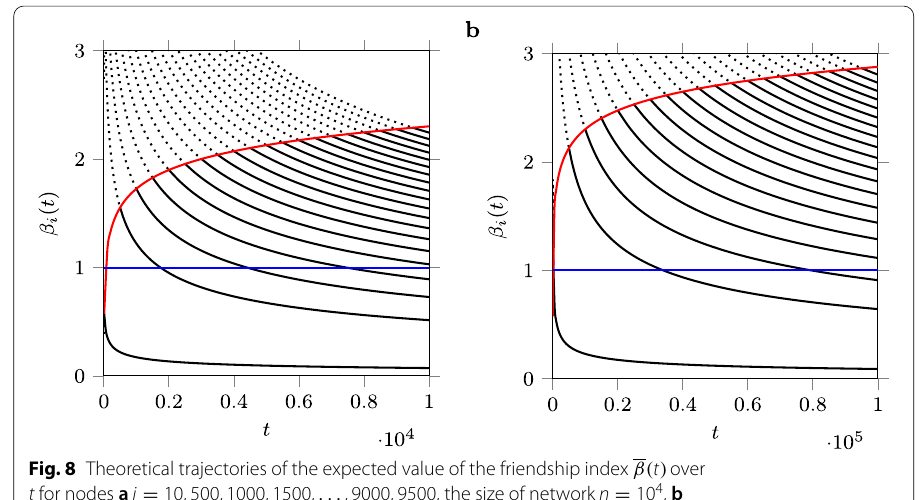
Fig. 8 Theoretical trajectories of the expected value of the friendship index β( t ) over t for nodes a i = 10,500,1000,1500, ... ,9000,9500 , the size of network n = 10 4 , b i = 100,5000,10000,15000, ... ,90000,95000 , the size of network n = 10 5